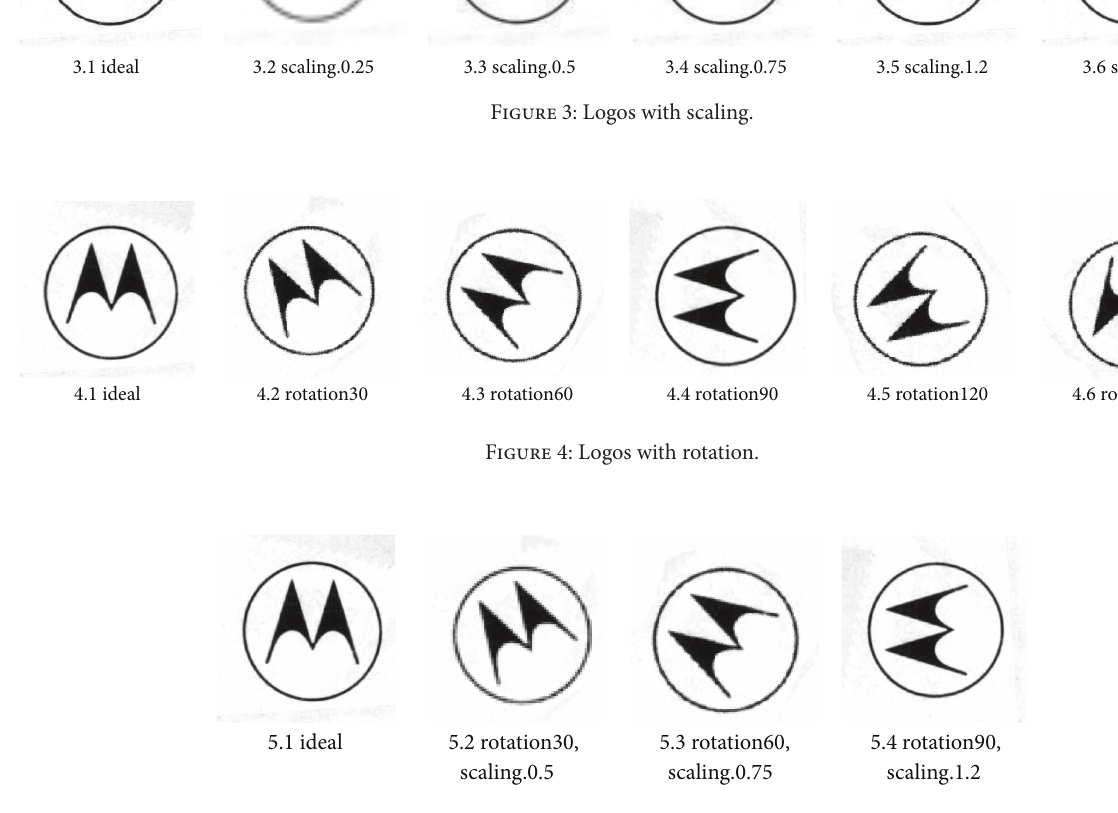
Figure 5: Logos with rotation and